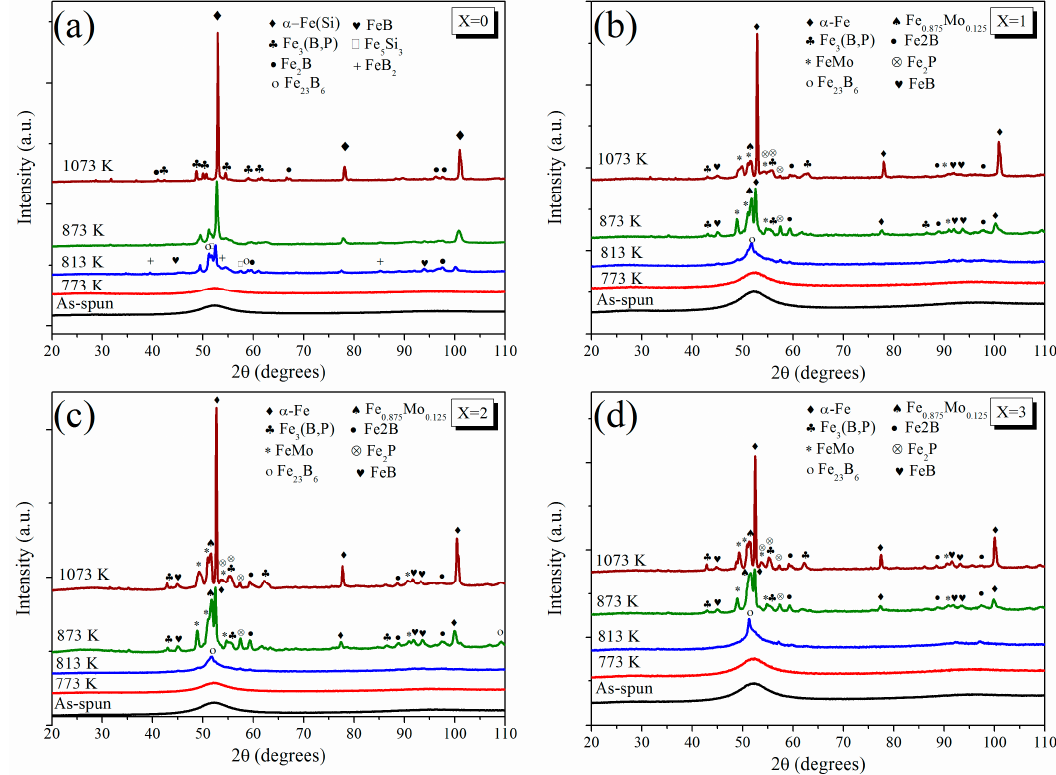
Figure 4. XRD patterns of the Fe 76 Si 9 − x B 10 P 5 Mo x ( x = 0, 1, 2 and 3) glasses showing the structural evolution after annealing at different temperatures. ( a ): x = 0; ( b ): x = 1; ( c ): x = 2; ( d ): x = 3.